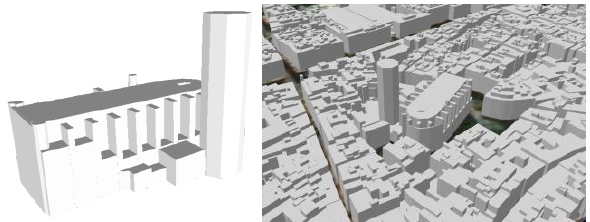
Figure 7: LOD1 building model from the 1:1000 topographic database of